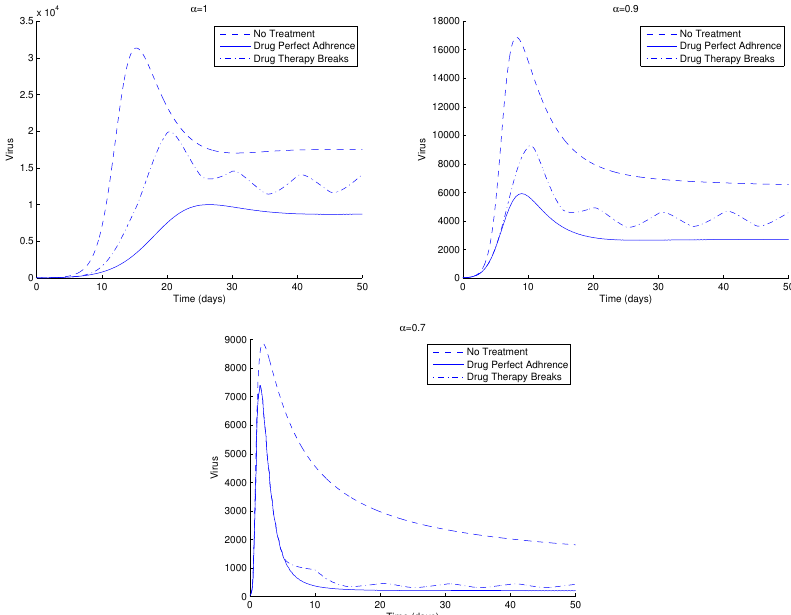
Figure 8. HIV, viral load, V , of system (1) for three different therapy strategies and for α = 1 ( top left ), α = 0.9 ( top right ) and α = 0.7 ( bottom ). Parameter values and initial conditions in the text, except R k = 1. For more information, see text.